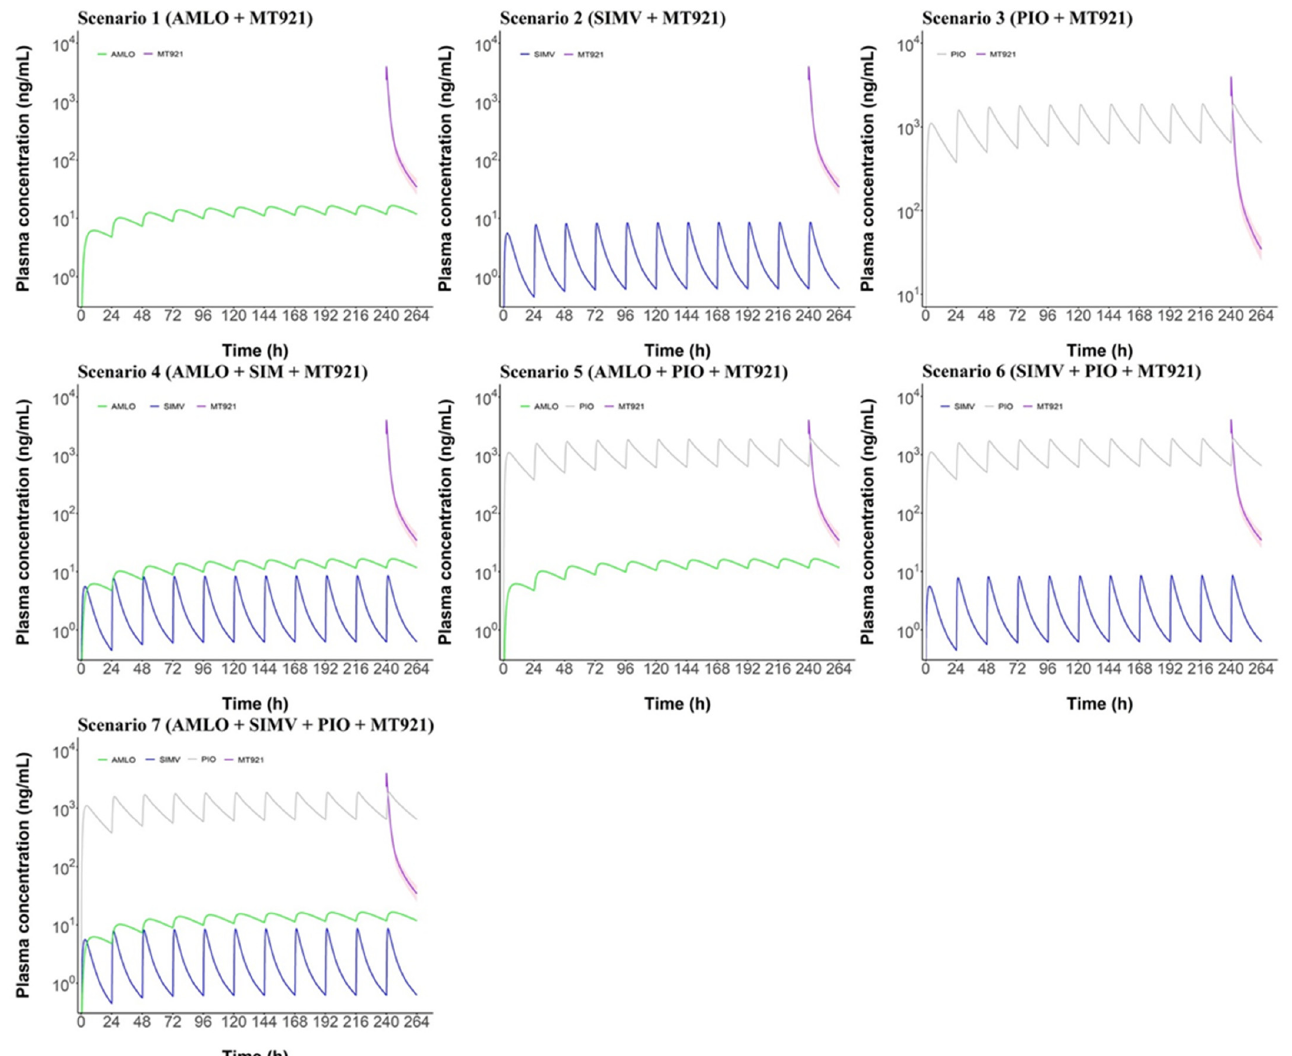
Figure 3. Semilogarithmic graph comparing plasma concentration of MT921 administered alone and co-administered. Chronic disease drugs were administered for 9 days, once a day. At 10 days, 150 mg of MT921 was co-administered with chronic disease drugs. After administration, MT921 concentration was predicted. The purple line is a MT921-only population plasma concentration. The pink shade area is the 5–95% range of MT921 co-administration population plasma concentration. The green line is AMLO. The blue line is SIM. The gray line is PIO.